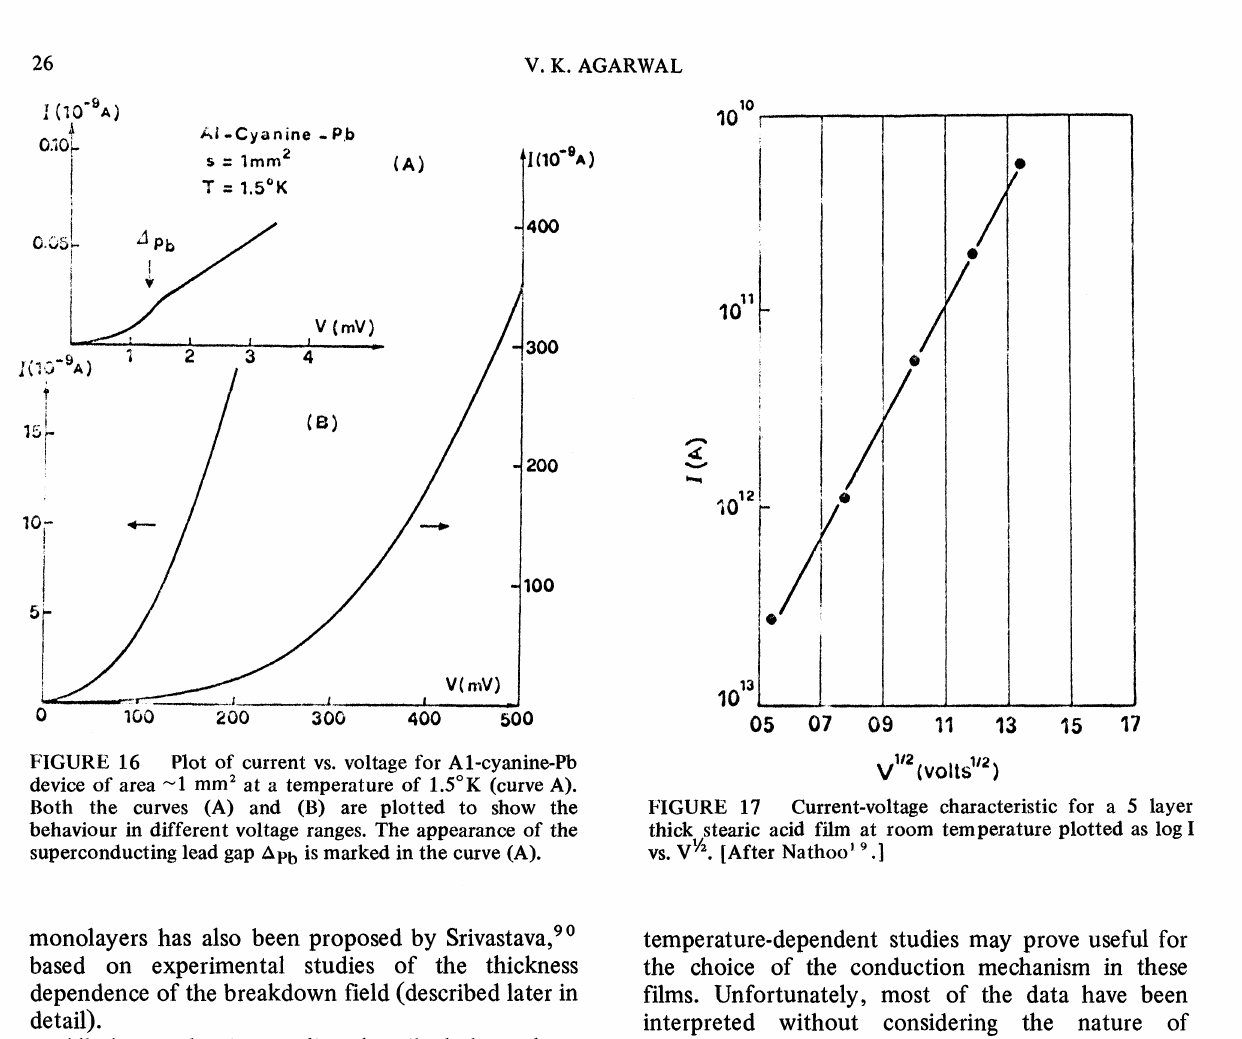
v V (volts /) FIGURE 17 Current-voltage characteristic for a 5 layer thick stearic acid film at room temperature plotted as log vs. V V2. [After Nathoo’